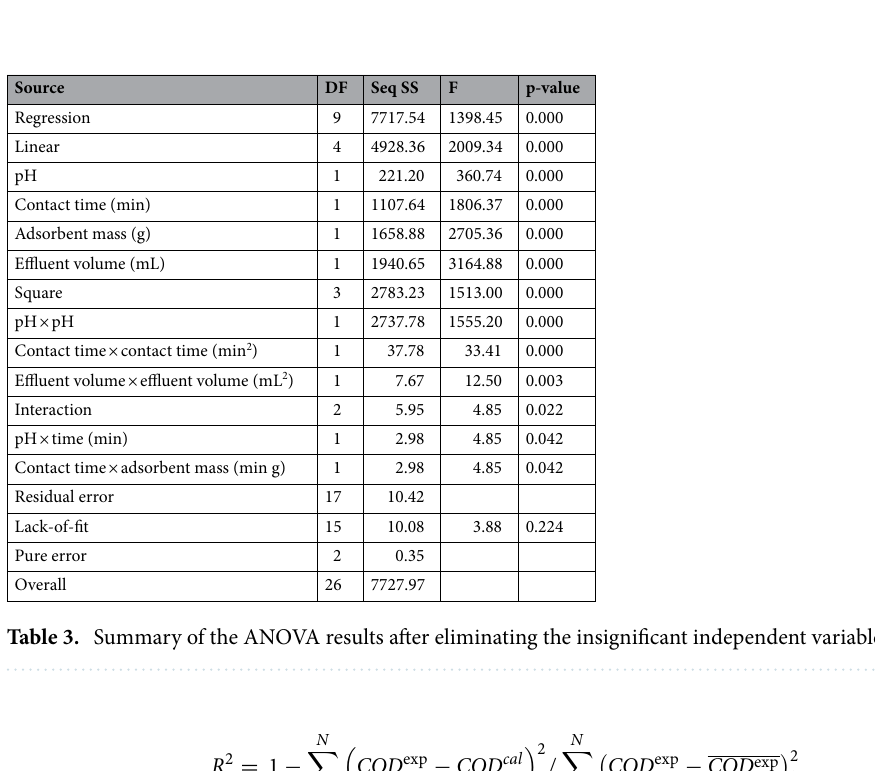
Table 2. ANOVA outcomes for monitoring wastewater COD removal using the TiO 2 –chitosan nanocomposite.